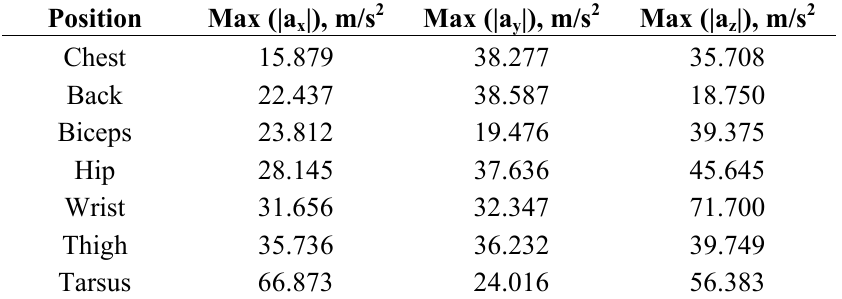
Table 2. Maximum accelerations observed in three